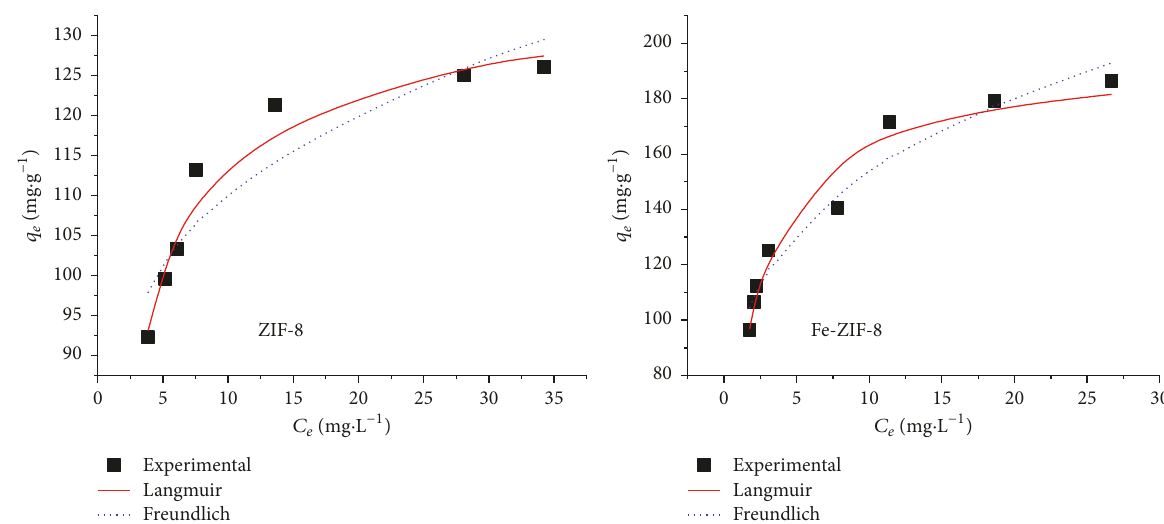
Figure 12: Langmuir and Freundlich isotherm models of adsorption RDB dye onto ZIF-8 and Fe-ZIF-8 ( 𝐶 𝑚